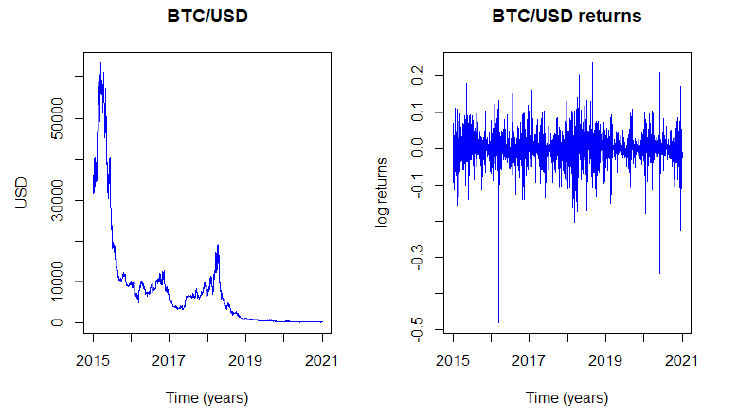
Figure 1. Plot of BTC/USD prices (left) and one-day log returns (right)